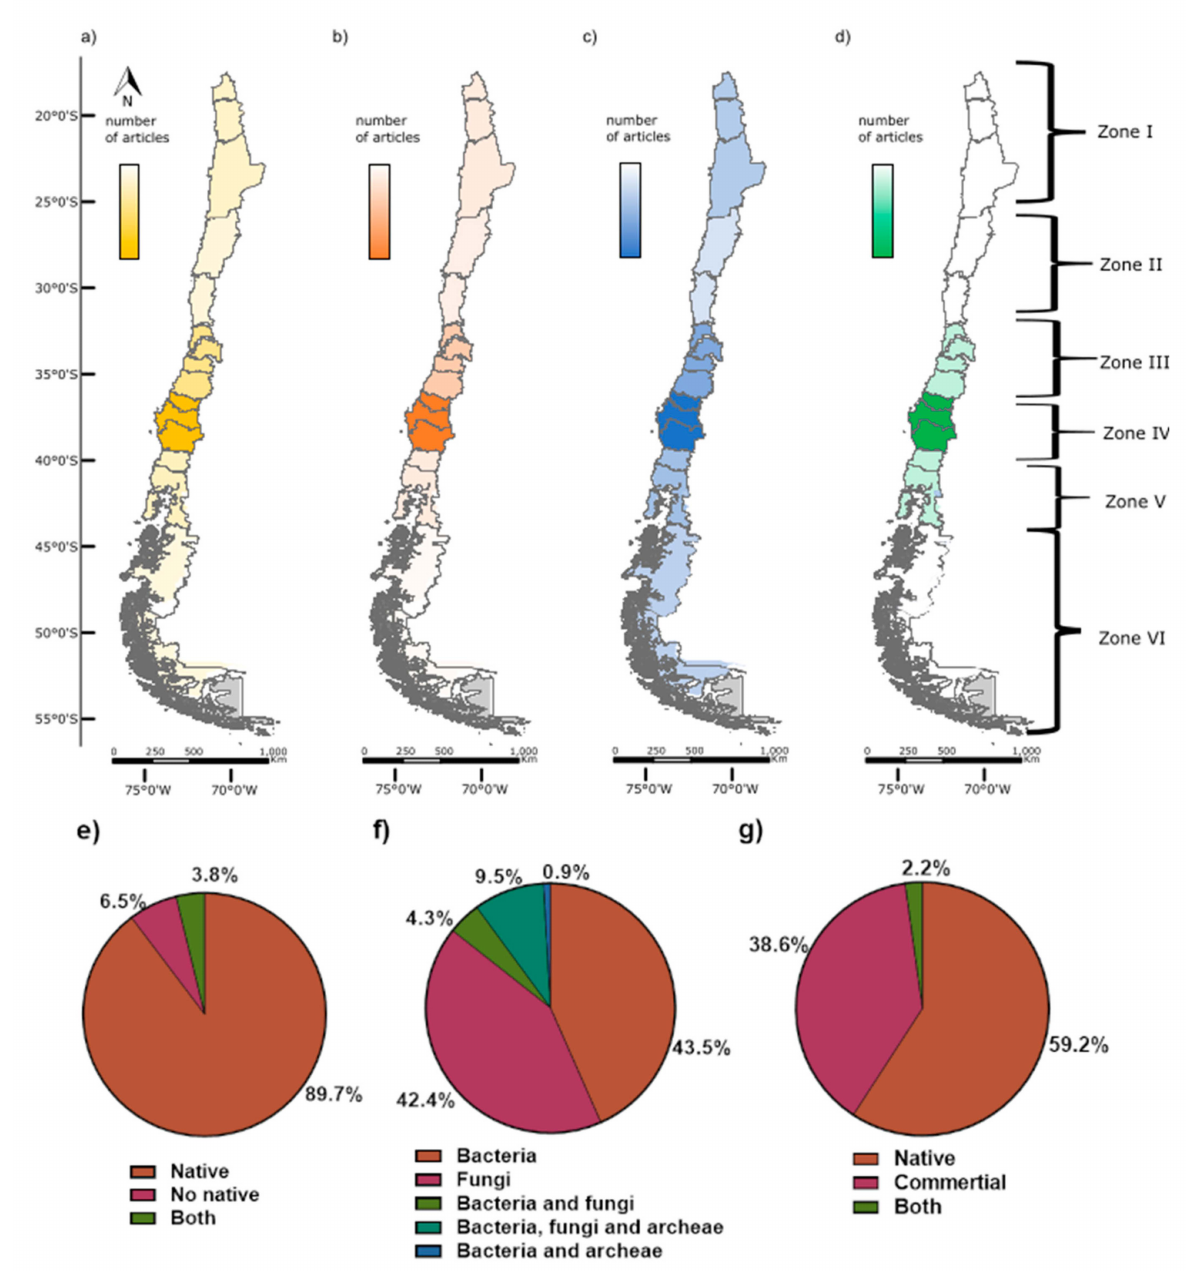
Figure 2. Geographical distribution of the PGPM studies in Chile and general study focus. ( a ) Spatial distribution of all articles (183) in this review; ( b ) articles based on culture-dependent techniques (105); ( c ) articles based on culture-independent techniques (71); ( d ) articles considering both type techniques (7); ( e ) Biogeographic origin of the microorganisms in all articles; ( f ) Taxonomic identity of the microorganism (domain level) in all articles; ( g ) Biogeographic origin of the plant host in all articles. The total number of articles is 183. (For the description of zone I to zone VI, please refer to methodological Section